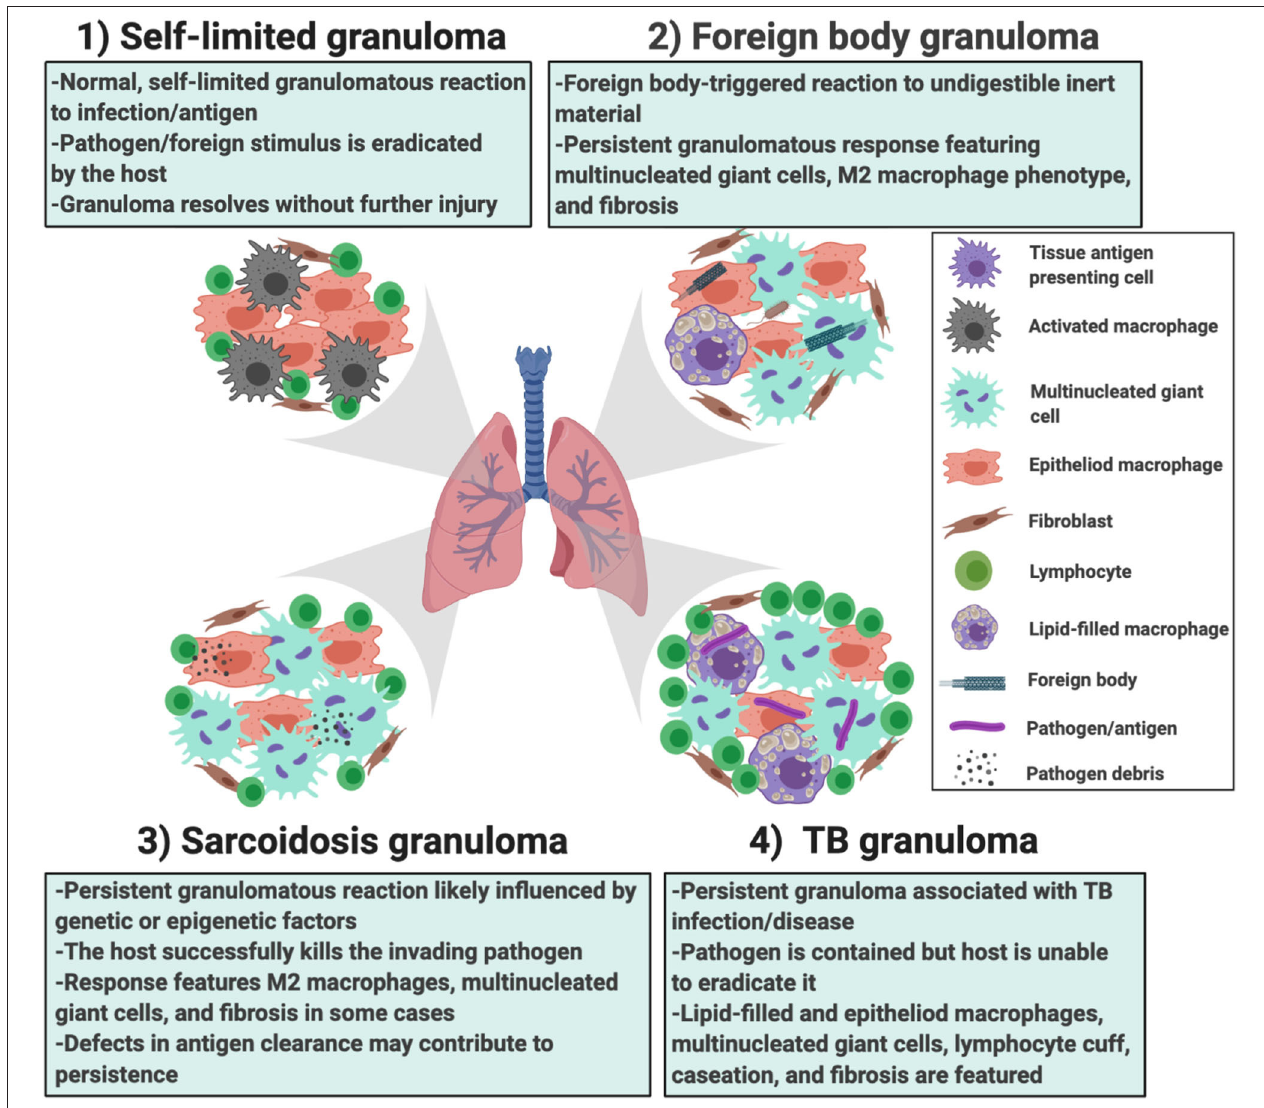
FIGURE 8 | Different scenarios in which the in vitro human granuloma model can be used to better understand the dynamic, multicellular mechanisms underpinning distinct granulomatous immune responses that occur in humans ranging from (1) self-limited immune reactions; (2) foreign body immune reactions; (3) sarcoidosis granulomas; and (4) TB granulomas. The granuloma model can be used to test mechanistic hypotheses as well as further our understanding of the importance of environmental (e.g., the type of antigen used to promote granulomas) and host factors (e.g., genetics/race, epigenetic factors/sex, etc.) in these reactions. They can also be used for throughput testing of new potential